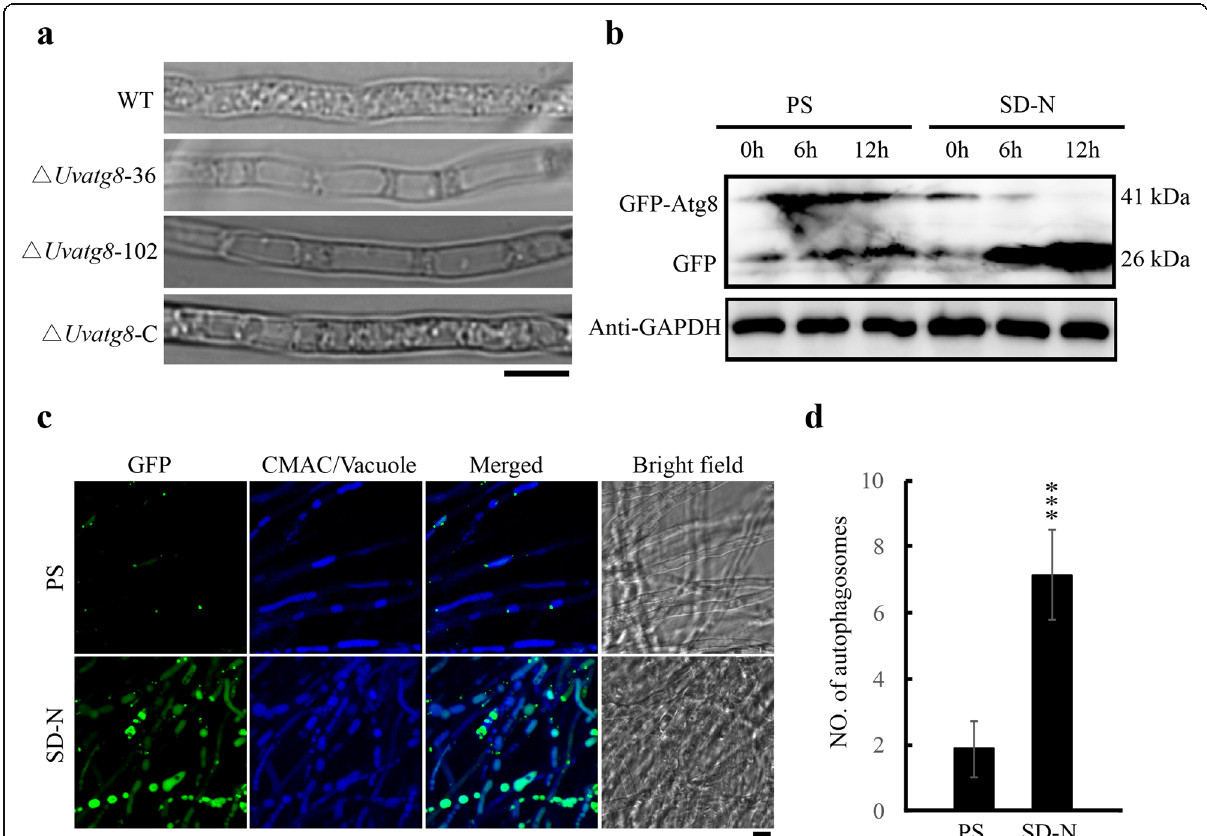
Fig. 3 UvAtg8 is essential for the autophagy in Ustilaginoidea virens . a, Autophagy was blocked in Δ Uvatg8 mutants. The strains were cultured in the PS (potato sucrose medium) medium for 3 d, following subjected to SD-N (nitrogen starvation condition) medium for 4 h to determine the autophagic affuxes in the WT and Δ Uvatg8 strain. The images were taken by bright field microscopy. b, The degradation of the GFP-UvAtg8 was observed under nitrogen starvation condition via Western blot assay with an anti-GFP. GAPDH was used as an internal reference. c, Confocal microscopy image of the GFP-UvAtg8 strain under nitrogen rich and starvation condition. The indicated strain was cultured in the PS medium for 3 d, and then shifted to an SD-N medium for 12 h. The vacuoles were stained with CAMC (7-amino-4-chloromethylcoumarin) before the observation using confocal laser scanning microscope. Scale bar = 5 μ m. d, The number of autophagosomes was counted. The data were subjected to Duncan ’ s Test and the significant difference was indicated by asterisks (***, p <